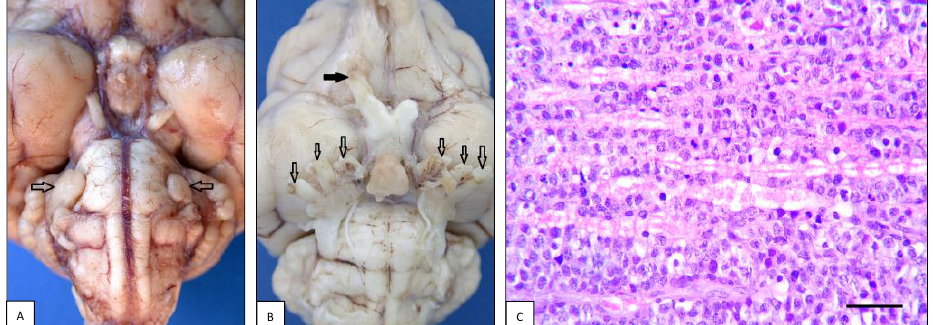
Figure 6. Peripheral nervous system lymphoma: neurolymphomatosis. ( A ) Case #21. Dog brain, ventral view. Both roots of the trigeminal nerve are enlarged due to infiltration of neoplastic cells (open arrows). ( B ) Case #89. Cat brain, ventral view. Ventral aspect of cat brain with neurolymphomatosis. All three branches of both trigeminal nerve roots (open arrows) and right optic nerve (black arrow) are enlarged due to infiltration of neoplastic cells. ( C ) Case #9. Canine sciatic nerve longitudinal section. Neoplastic cells extensively infiltrate the endoneurial tissue. Nerve fibers show diffuse myelin degeneration (H&E, bar = 100 µm).